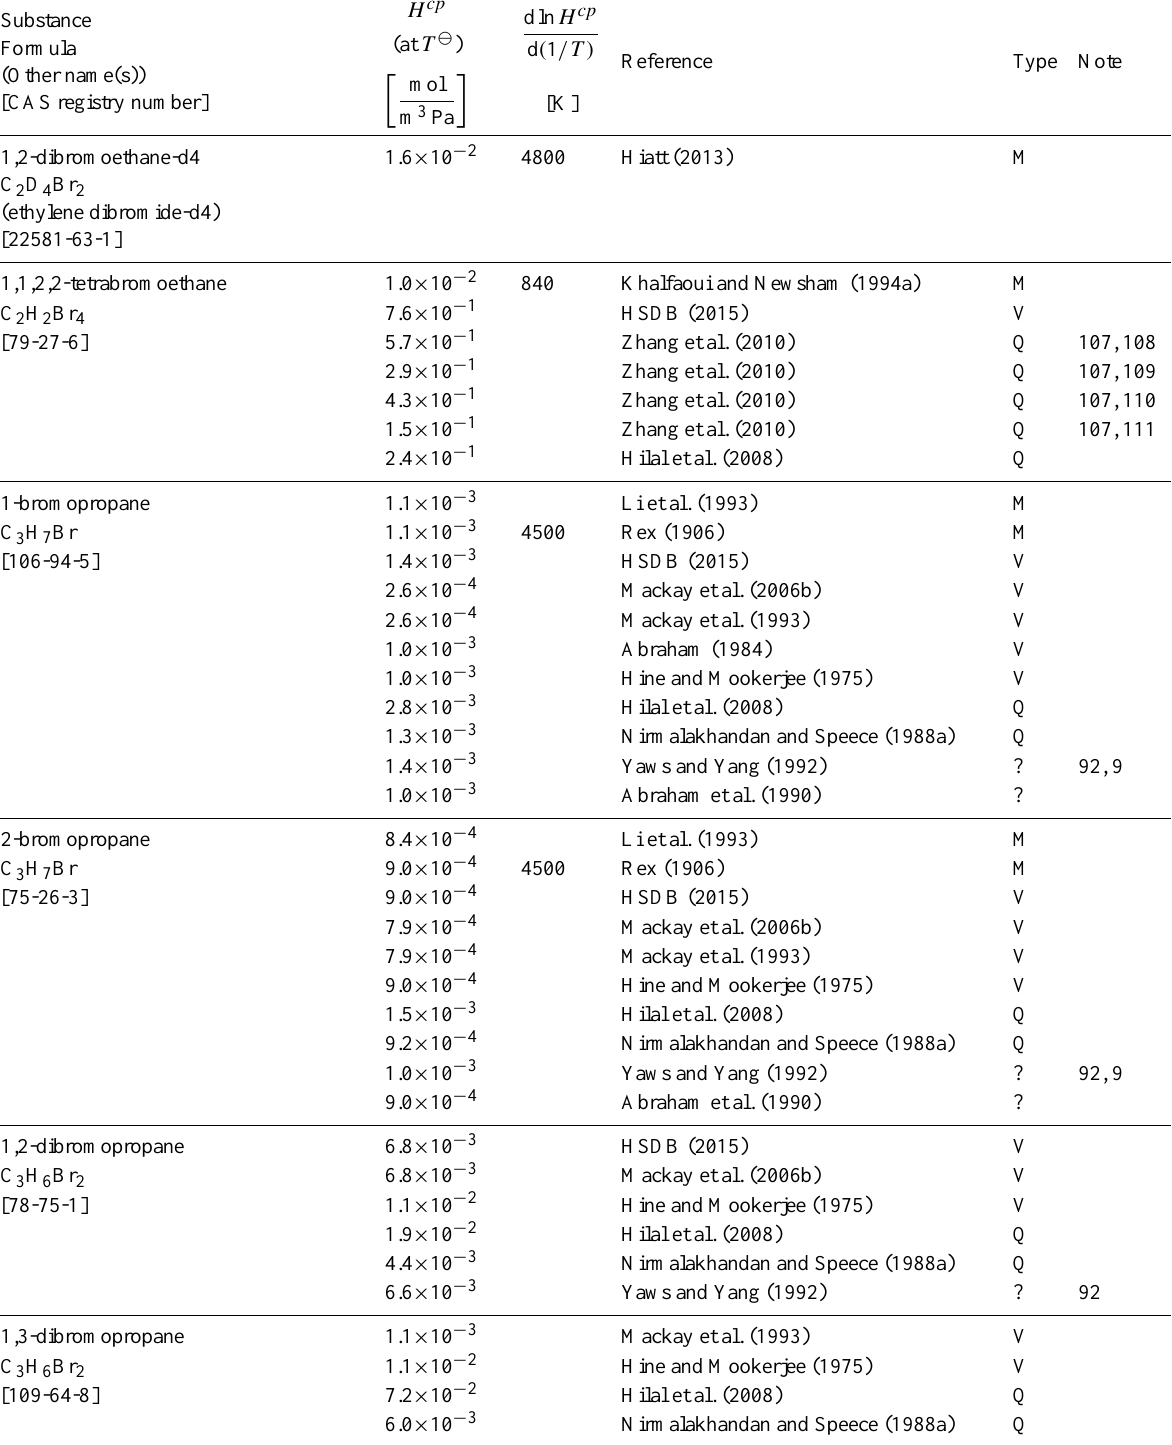
Table 6: Henry’s law constants for water as solvent